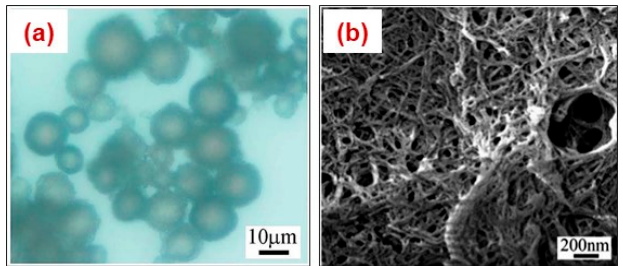
Figure 3. SEM images of PUA particles prepared at 30 ◦ C in acetonitrile ( a ), and in acetone ( b ) under reciprocating shaking (150 oscillations per minute). Monomer concentration: 1.0% w/w [90]. Adapted from Ref. [90] with permission from The Royal Society of Chemistry.